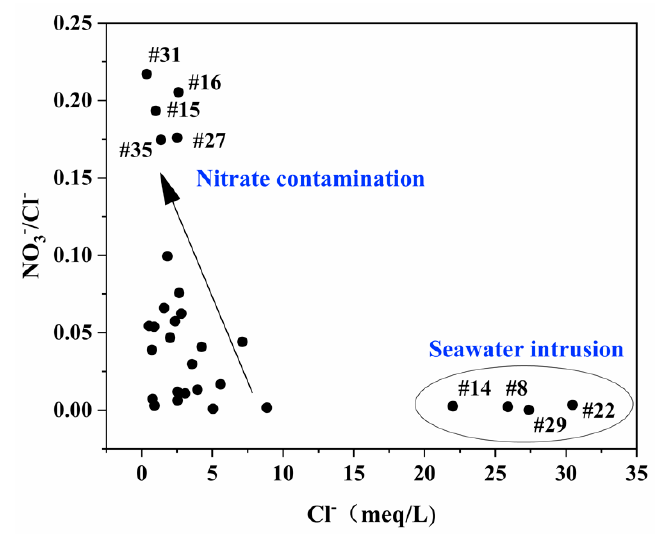
Figure 8. Scatter diagram of NO 3 − /Cl − vs. Cl − .